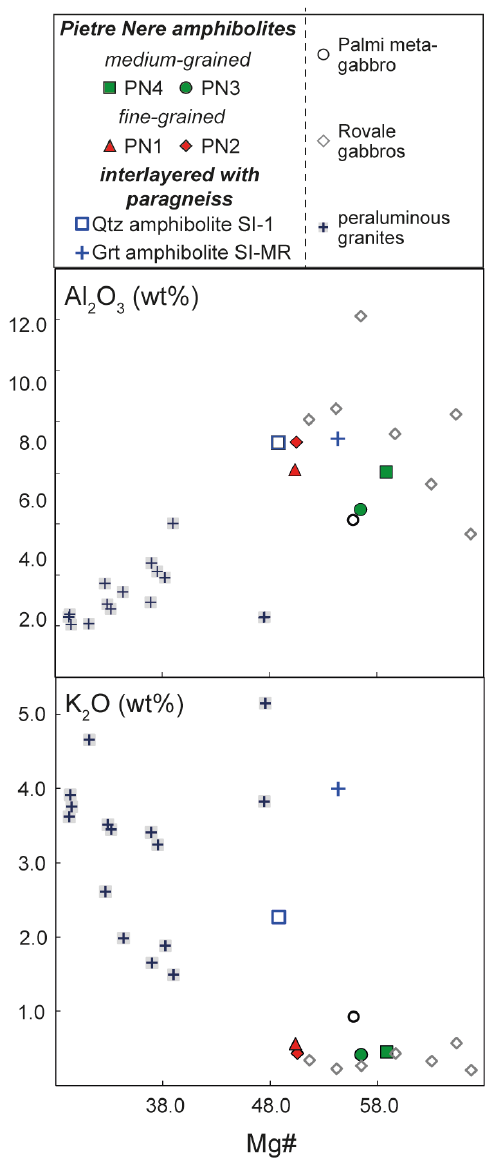
Figure 10. Major-element whole-rock variation (calculated water free): Al 2 O 3 (wt%) and K 2 O (wt%) vs. Mg#. The compositions of metagabbro associated with Palmi tonalitic gneisses (Rottura, 1985) of Rovale gabbros (Sila Massif, Caggianelli et al., 1994) and late- Variscan peraluminous granites (central and southern Calabria, Rot- tura et al., 1993; Fiannacca et al., 2019) are reported for